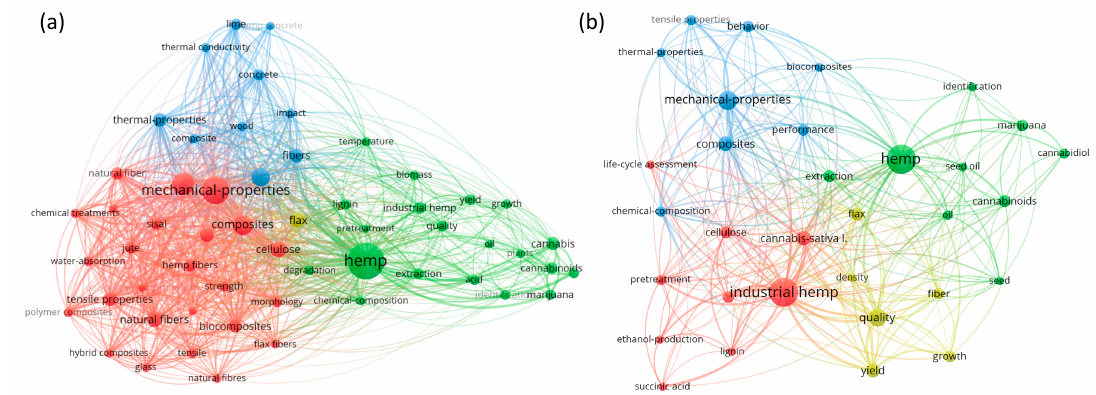
Figure 2. The keyword networks of ( a ) hemp and ( b ) industrial hemp in scientific articles from 2014 to 2020.